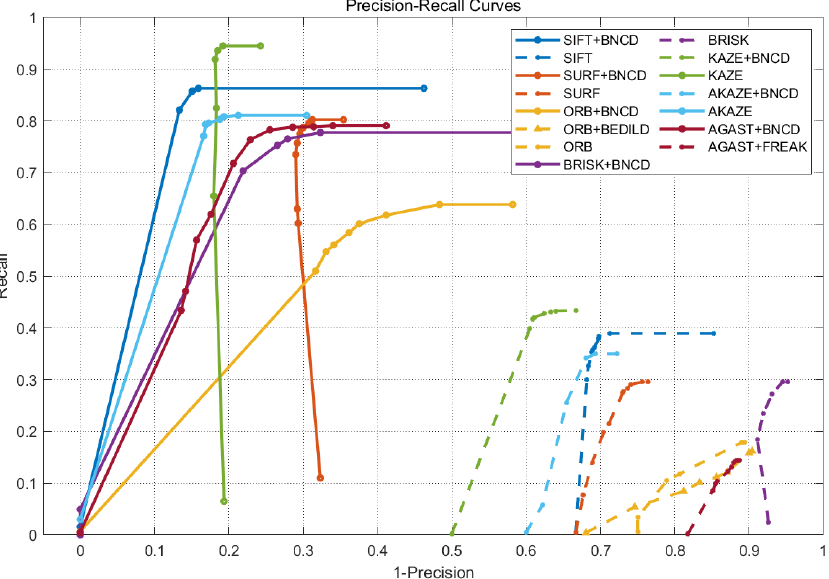
Figure 10. Recall-precision curves of BNCD and state-of-the-art descriptors on the circuit board.